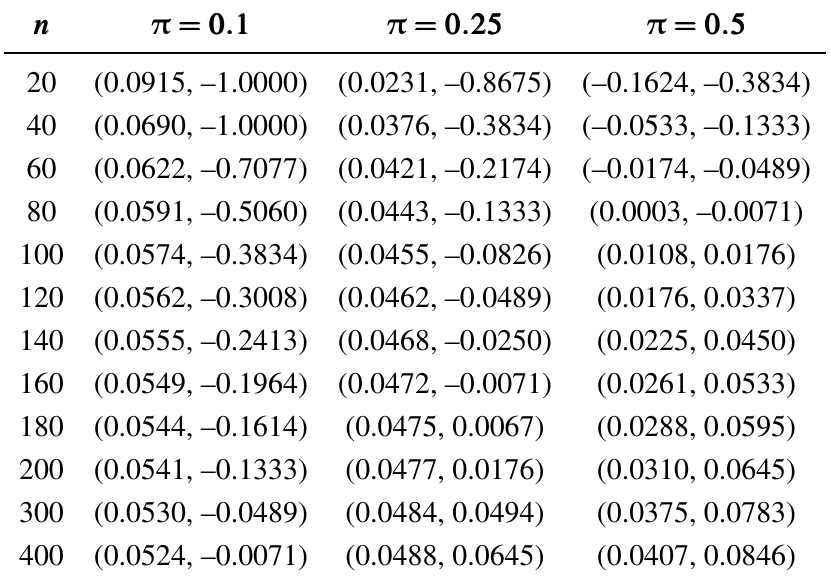
) in case of a predictive and prognostic prior, i.e. ; c (cid:3) 1 0